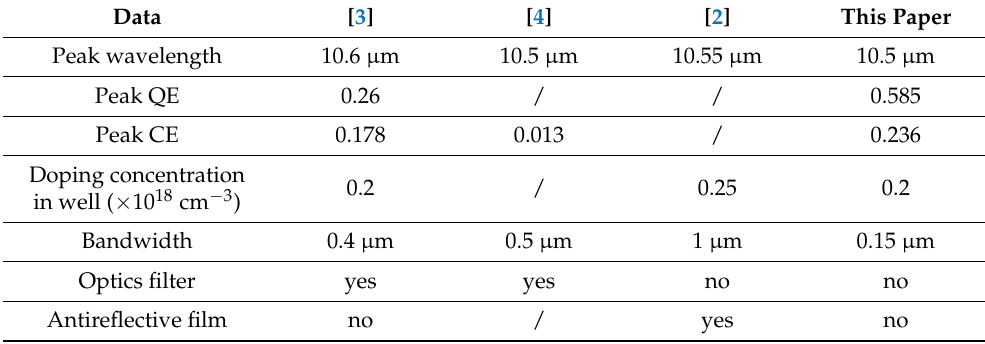
Table 1. Comparison among Quantum Well Micropillar Array and QWIPs in